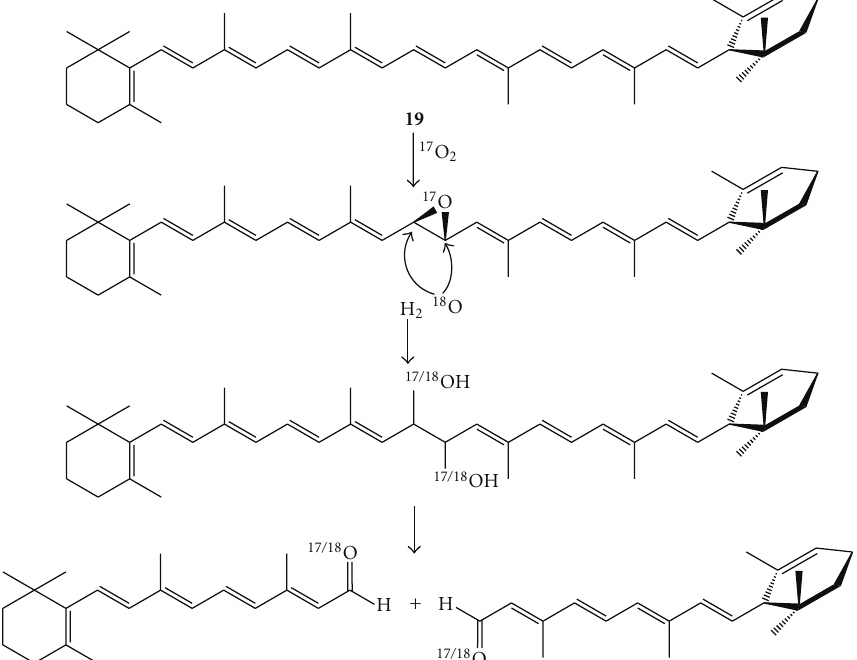
Scheme 8: The proposed mechanism for the C15-C15 (cid:4) double bond cleavage of β -carotene. Labelling experiment using 17 O 2 and 18 H 2